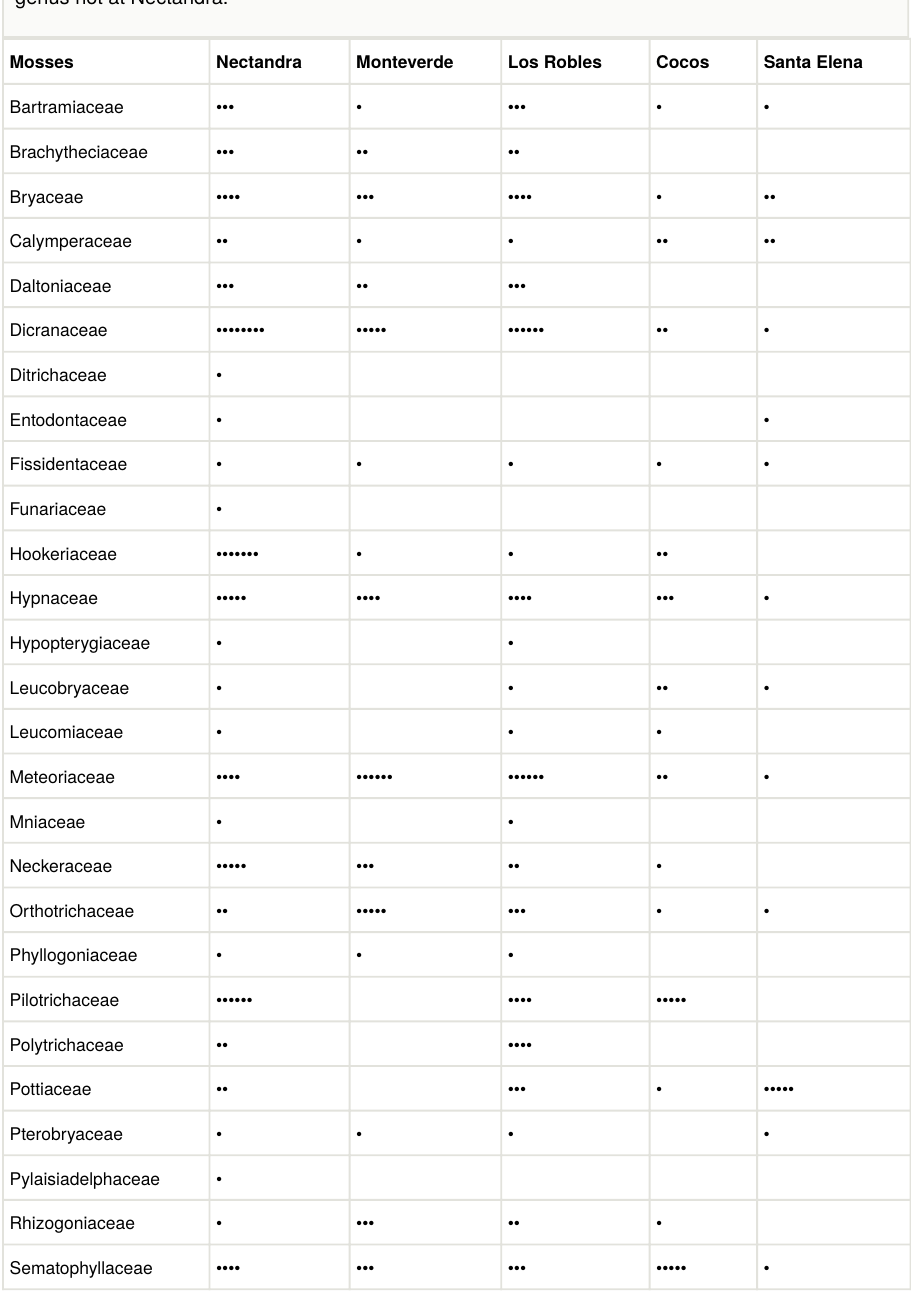
Table 3. Number of moss genera by family at the fi ve sites. Each dot (•) = one shared genus; Each (o) = genus not